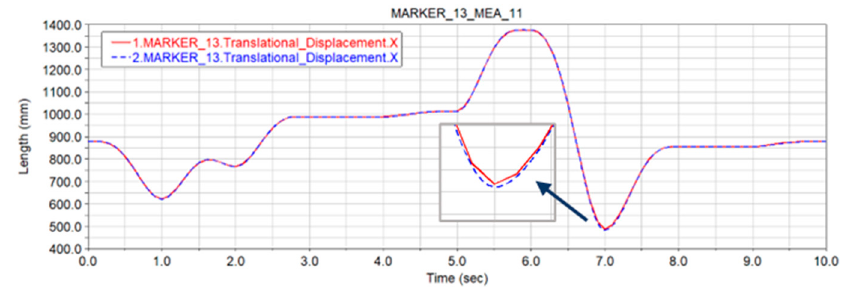
Figure 12. Comparison of simulation displacement curves in the x-direction.